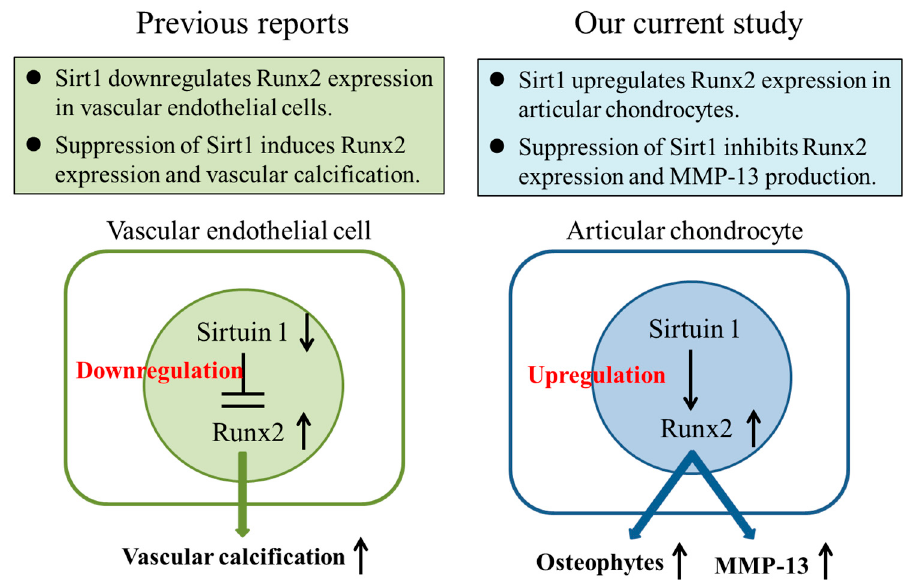
Figure 6. Summary of our current study. The NAD-dependent deacetylase Sirt1 may regulate the osteogenic transcription and chondrocyte hypertrophic factor Runx2 and matrix degrading enzyme MMP-13 in chondrocytes in OA. Arrow “ ↑ ” indicates upregulation, Arrow “ ↓ ” indicates downregulation.